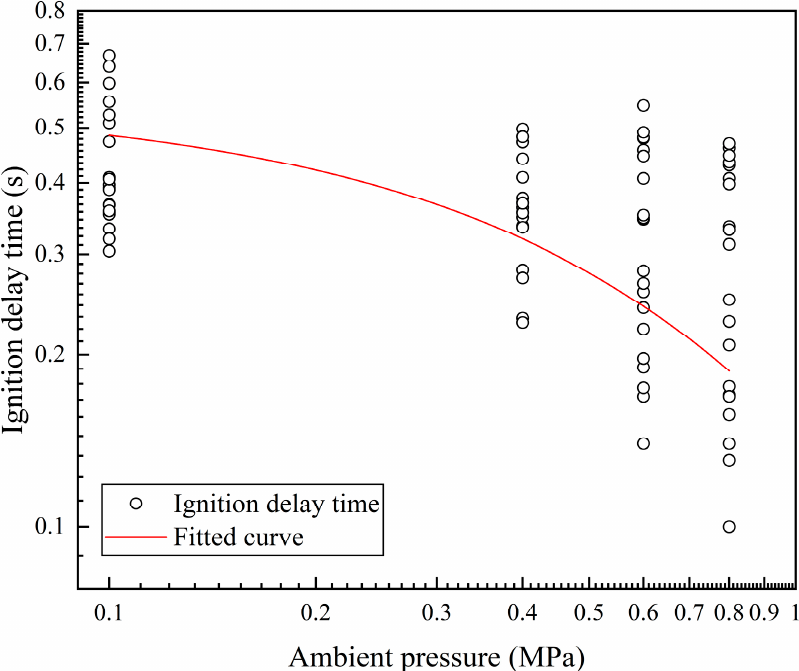
Figure 7. The ignition delay time of single Al-Li alloy microparticles at different ambient pressures.